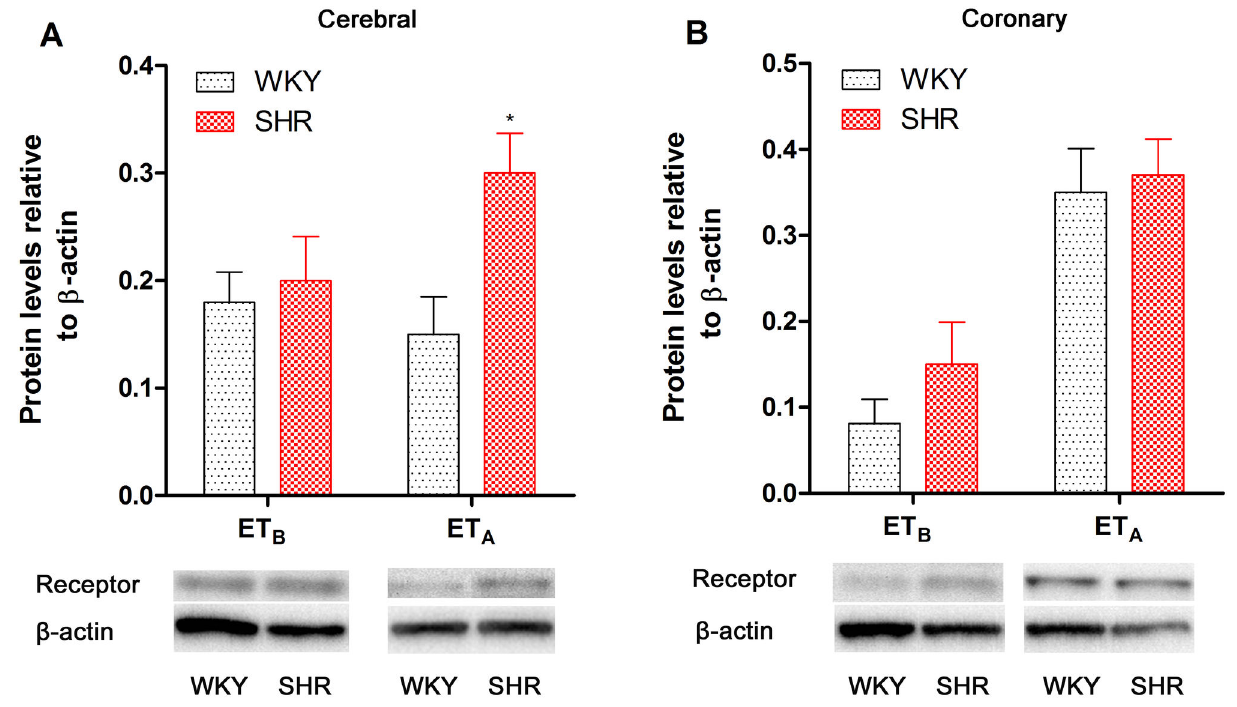
Figure 3. ET and ET receptor protein expression levels in SHR and WKY rat cerebral (A) and coronary (B) arteries. ET B A and ET receptor protein expression levels were expressed relative to β-actin levels. Each data point is derived from 7–8 animals A and is expressed as the mean ± SEM. Statistical analysis was performed using an unpaired Student’s t -test. * P <0.05 vs . WKY